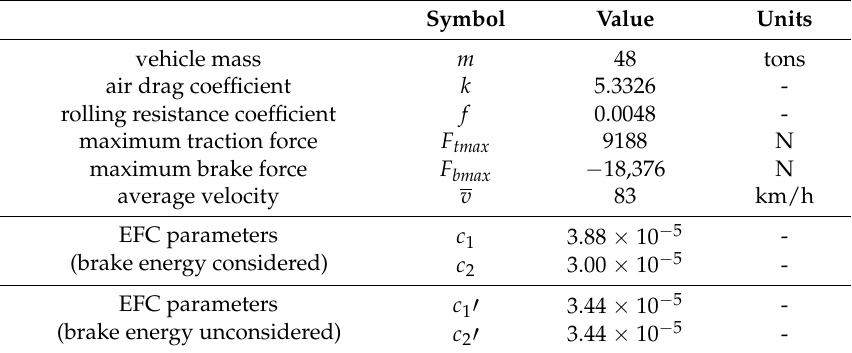
Table 1. Simulation parameters. EFC: equivalent fuel consumption.